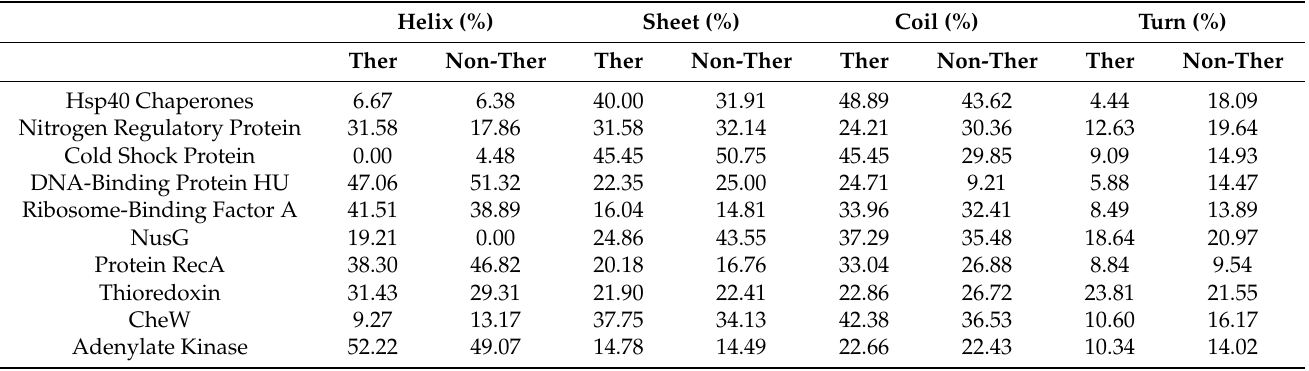
Table 1. Percentage of secondary structures in thermophilic (Ther) and non-thermophilic (non-Ther) proteins. Helix (%) Sheet (%) Coil (%) Ther Non-Ther Ther Non-Ther